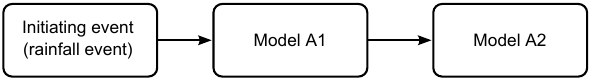
Fig. 4. Generic influence diagram: common initiating event (Scheme